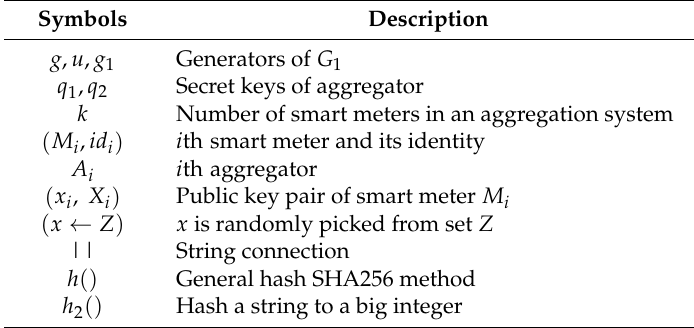
Table 4. Symbols used in the